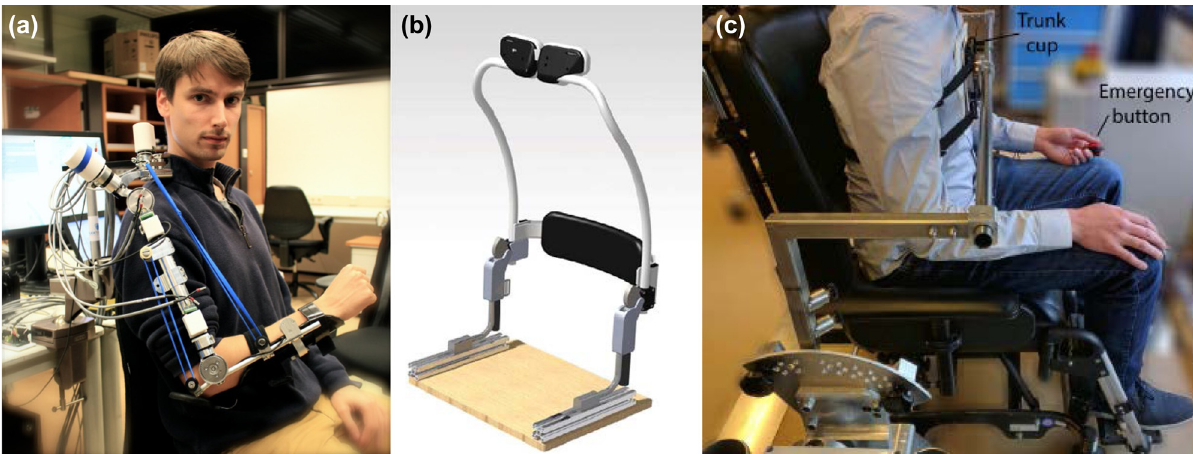
Figure 2: The fi gure illustrates the results of various WREs developed for people with DMD. ( a ) A complete arm active WRE for people with DMD, adapted from [ 7 ] ( Flextension A - Gear [ 28 ]) . ( b ) A trunk and neck passive WRE for people with DMD, adapted from [ 21 ] ( Symbionics 2.1 [ 27 ]) . ( c ) An active truck WRE for people with DMD, adapted from [ 21 ]